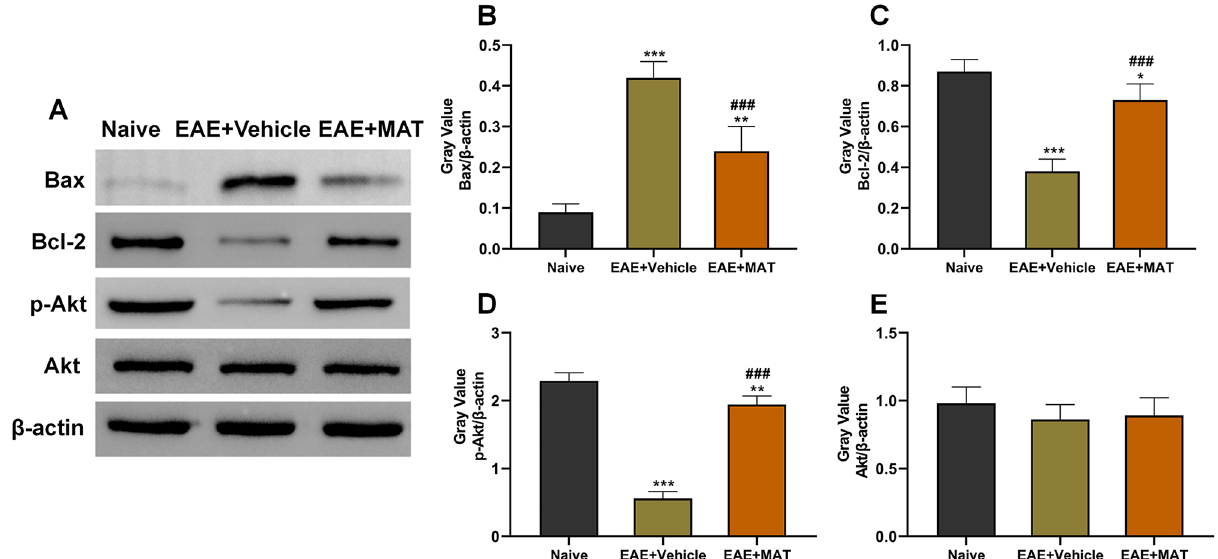
Figure 7. MAT treatment promoted the shift of the Bcl-2/Bax ratio back towards the antiapoptotic and Akt phosphorylation. The retinas were harvested from naive and MAT- or vehicle-treated rats. ( A ) Protein expression of Bax, Bcl-2, p-Akt and Akt was determined by Western blot. Ratio of gray value of Bax ( B ), Bcl-2 ( C ), p-Akt ( D ), Akt ( E ) to β-actin was calculated. Data represent mean ± SD (n = 5 per group). Multiple comparisons were performed using one-way ANOVA, followed by the Student–Newman–Keuls test. * P < 0.05, ** P < 0.01, *** P < 0.001, comparison with the naive group. ### P < 0.001, comparisons between vehicle- and MAT- treated